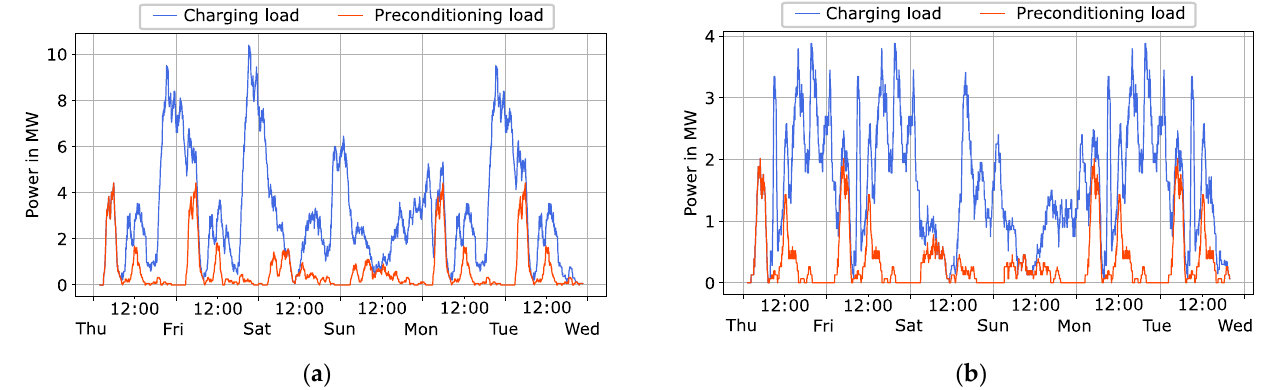
Figure 4. Total load profile (blue line) with the portion of load caused by the preconditioning (red line) for ( a ) BD1 and ( b ) BD2.